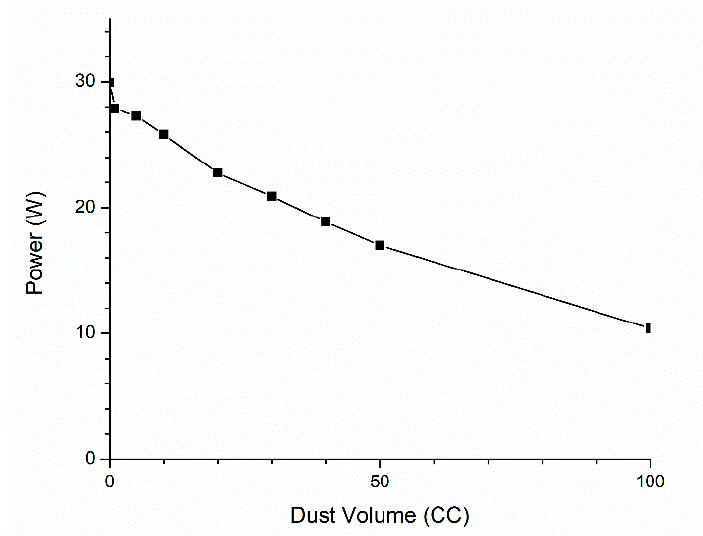
Figure 13. Graph of effect of dust on solar panel output power. The effect of the drone’s propellers due to different flight patterns on the amount of power output (efficiency) is shown in Tables 3–5 for dust levels of 20 CC, 50 CC, and 100 CC, respectively. Figure 14 shows the effect of drone based cleaning of the panel for 20 CC dust spread. der all circumstances. Table 3 demonstrates that, for 20 CC dust, the diagonal drone flight mode did not perform well compared to the horizontal and vertical patterns in terms of power efficiency, which was 19.15%. However, in this case, horizontal drone movement performed the best, regaining a power efficiency of 31.90%. Table 4 demonstrates that the increase in power efficiency for 50 CC dust spread was almost similar for the three drone movements. For 100 CC dust accumulation (Table 5), the horizontal flight method was found to be the most effective among the three methods, with an output power efficiency of 69.40%. On the other hand, the vertical movement of the drone resulted in the worst performance in terms of output power efficiency of 23.73%. Table 3. Power analysis of different drone flight methods (20 CC).